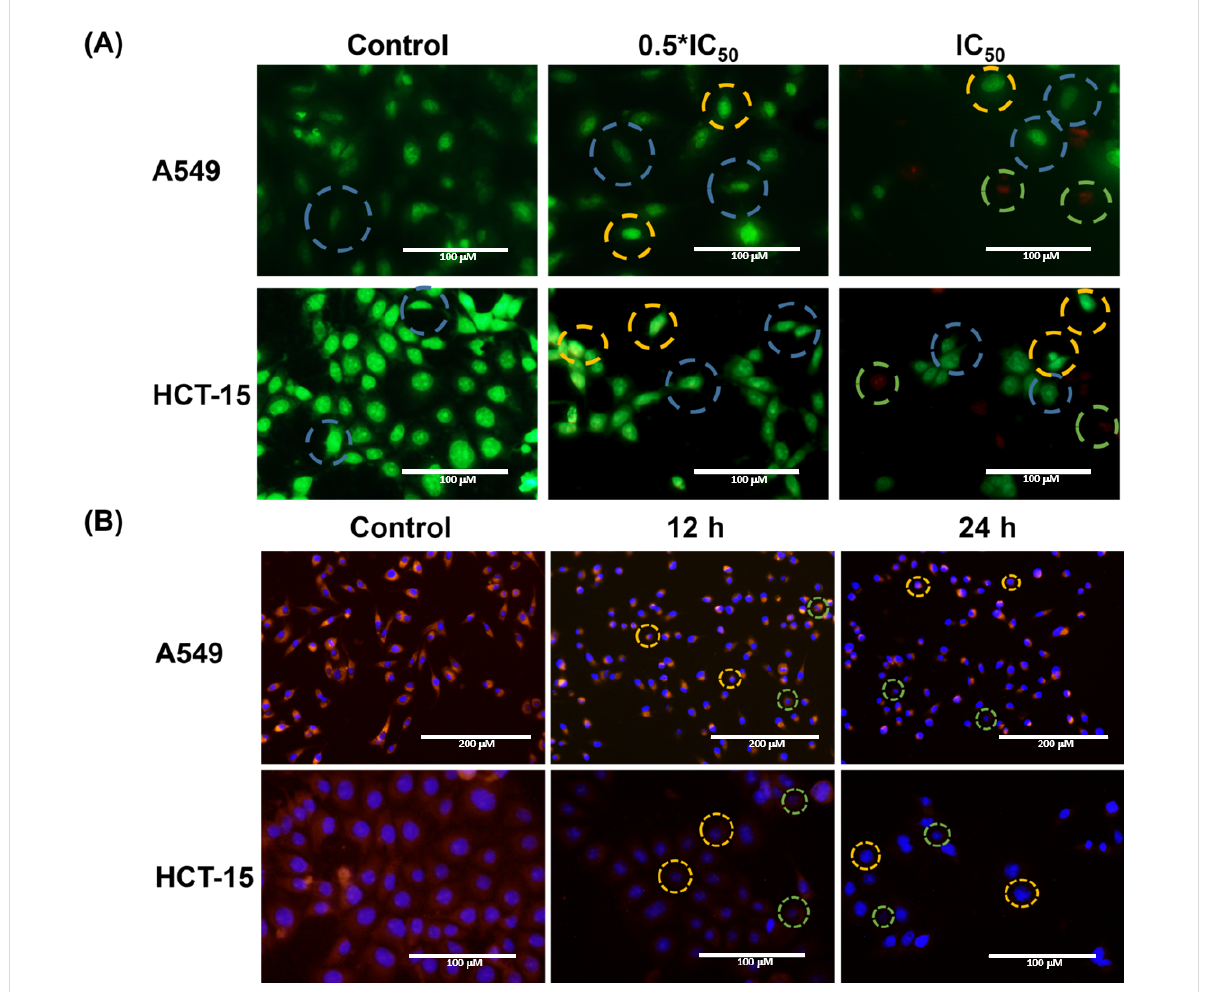
Figure 5: Fluorescence microscopy images of (A) AO/EB stained A549 and HCT-15 cells after 0.5 IC 50 and IC 50 with CaP@5-FU NP treatment for 24 h, showing multiple apoptotic events and (B) Hoechst 33342 and rhodamine B stained A549 and HCT-15 cells upon 12 h and 24 h incubation with CaP@5-FU NPs with respect to the untreated control visualises the morphological changes after CaP@5-FU NP treatment. Scale bars = 100 µm, except for A549 with scale bars = 200